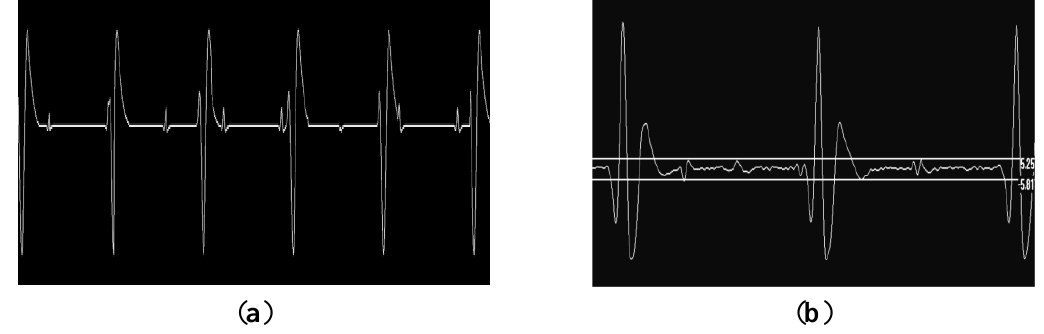
Figure 3. ( a ) Five maternal cycles of the simulated maternal and fetal ecg waveform used for the gating tests. This waveform was played from a PC soundcard and attenuated to the peak level expected for maternal in vivo signals (100 μV); ( b ) Two cycles of the signal received over the Bluetooth interface using the six metre, high resistance MR compatible leads showing the additional noise introduced. The measured ‘fetal’ signal from the simulator measured about 10 μV.